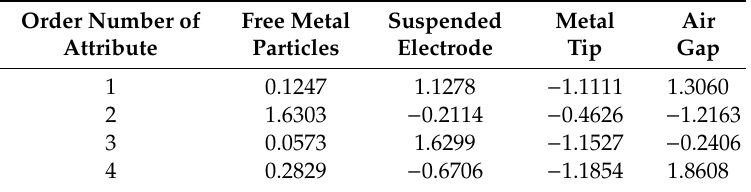
Table 2. Values of attributes